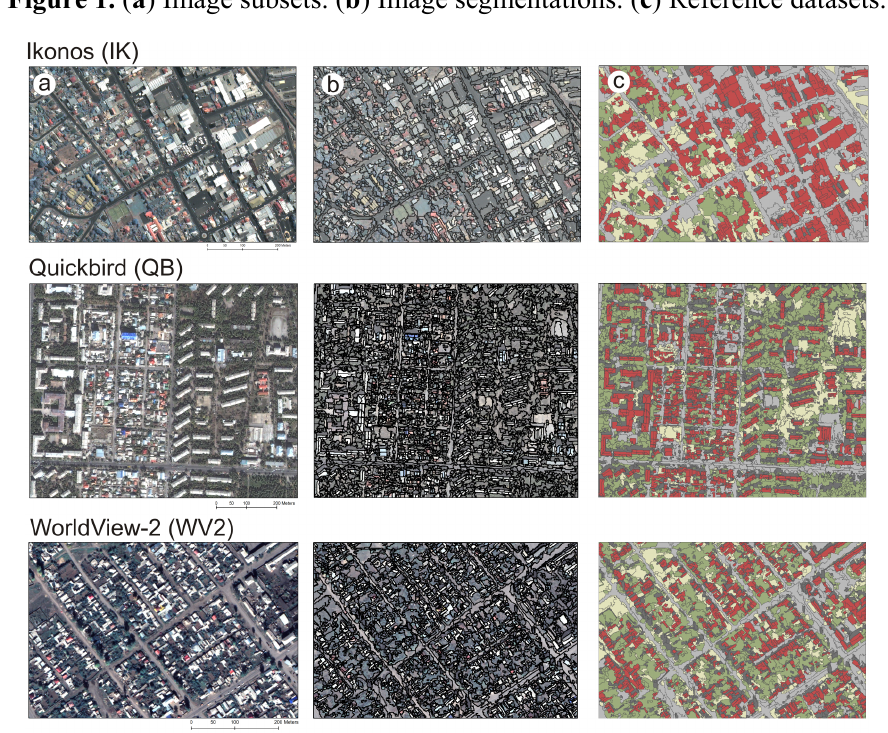
Figure 1. ( a ) Image subsets. ( b ) Image segmentations. ( c ) Reference